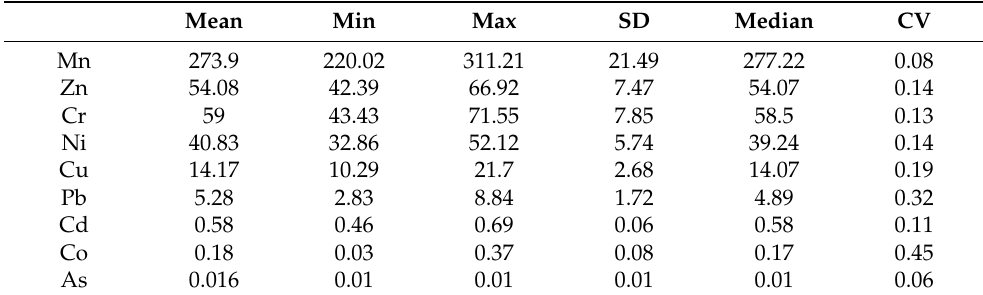
Table 2. Metal concentrations (mg/kg) in the soil samples collected from Liwa, Abu Dhabi. SD is the standard deviation and CV is the coefficient of